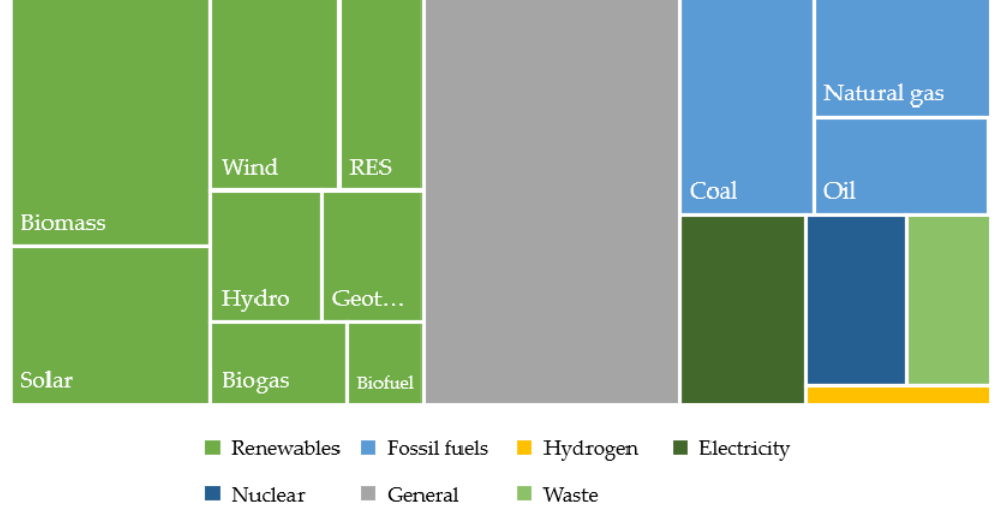
Figure 12. Type of source. Source: Authors; N = 4284. Note: Individual energy sources were coded separately, so N is larger than the size of the dataset.